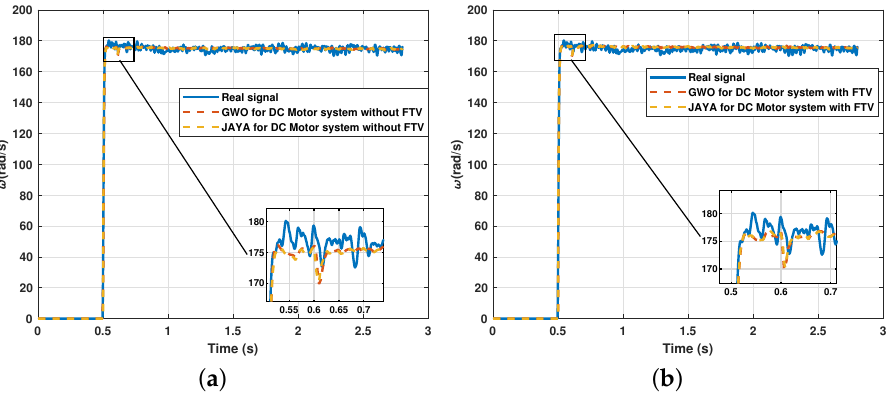
Figure 13. Comparison between estimated signal and real measured signal in the electromechanical system: ( a ) Comparison of Jaya and GWO & FTV for the electromechanical system with real signals; ( b ) Comparison of Jaya and GWO for the electromechanical system with real signals.